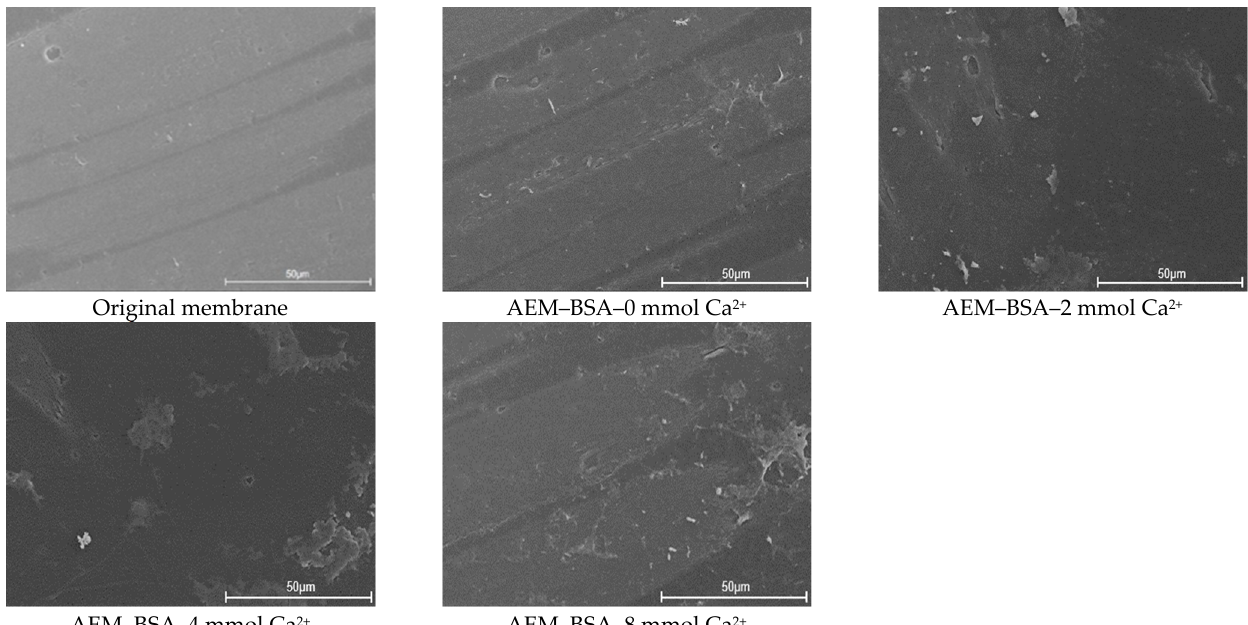
Figure 6. SEM images of original and used AEMs in the AEM–SA system with different calcium ion concentration.